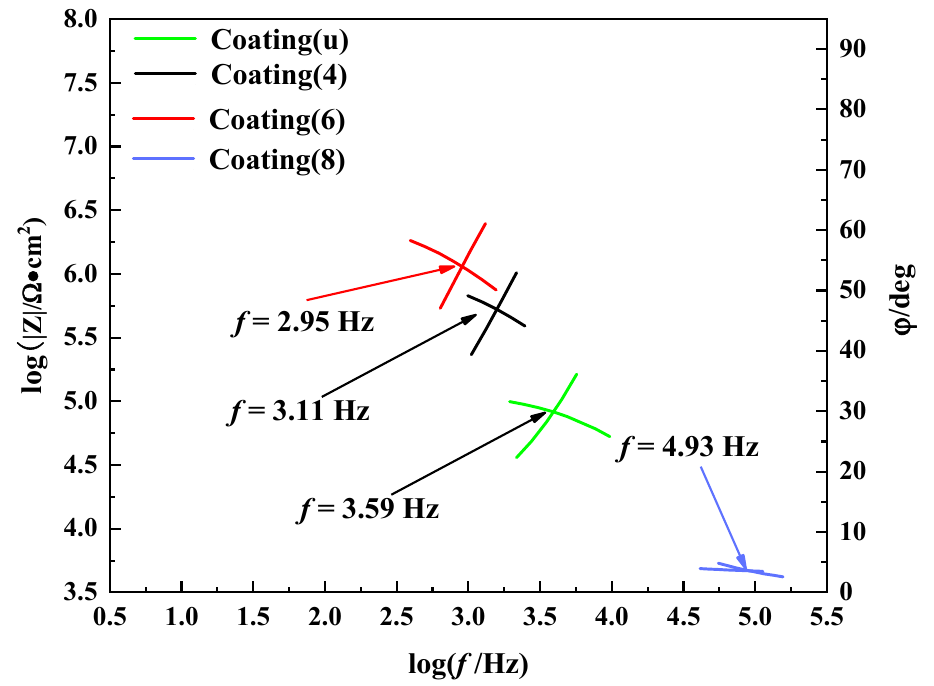
Figure 11. IBP of the coating(u) and coating(x) (x = 4, 6, 8).